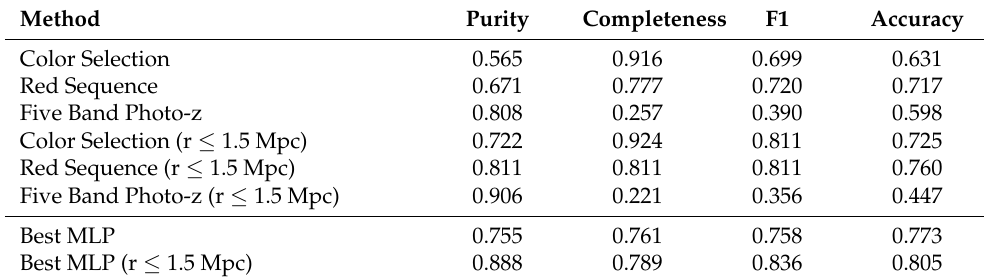
Figure 8. The ROC curve of our best model. The diagonal line is a random classification with AUC = 0.5, which has no classification power, plotted for comparison. The further away from this diagonal line, the better our classification performance. Table 3. Comparisons of various non-spectroscopic methods of the cluster